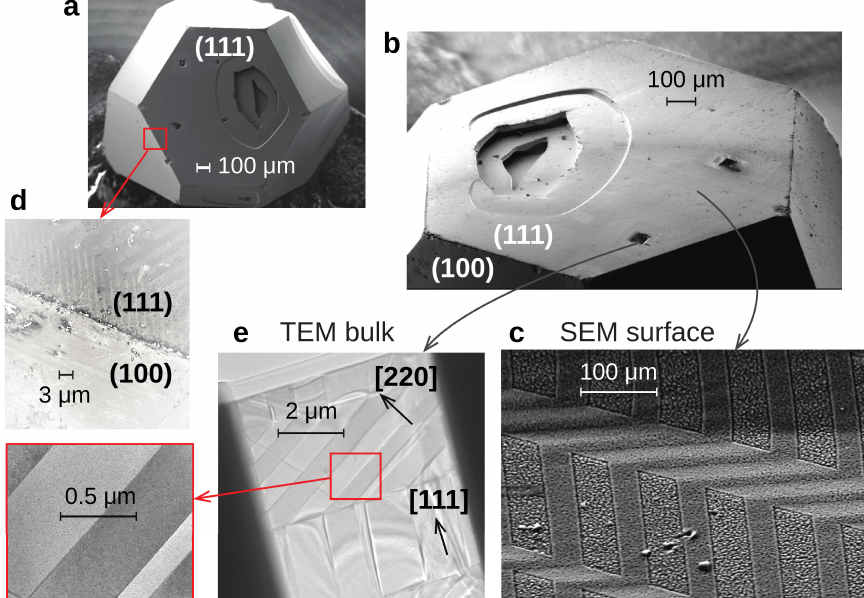
Figure 1. Collection of electron micrographs of a GeTe bulk crystal. ( a , b ) low resolution images depicting the shape of the mm-sized crystal. ( c , d ) higher magnification images with location on the bulk crystal indicated in ( a , b ). In particular, ( c ) shows a domain pattern on a (111) surface obtained by SEM; ( e ) TEM image on cross sectional lamella cut out using a focused ion beam.